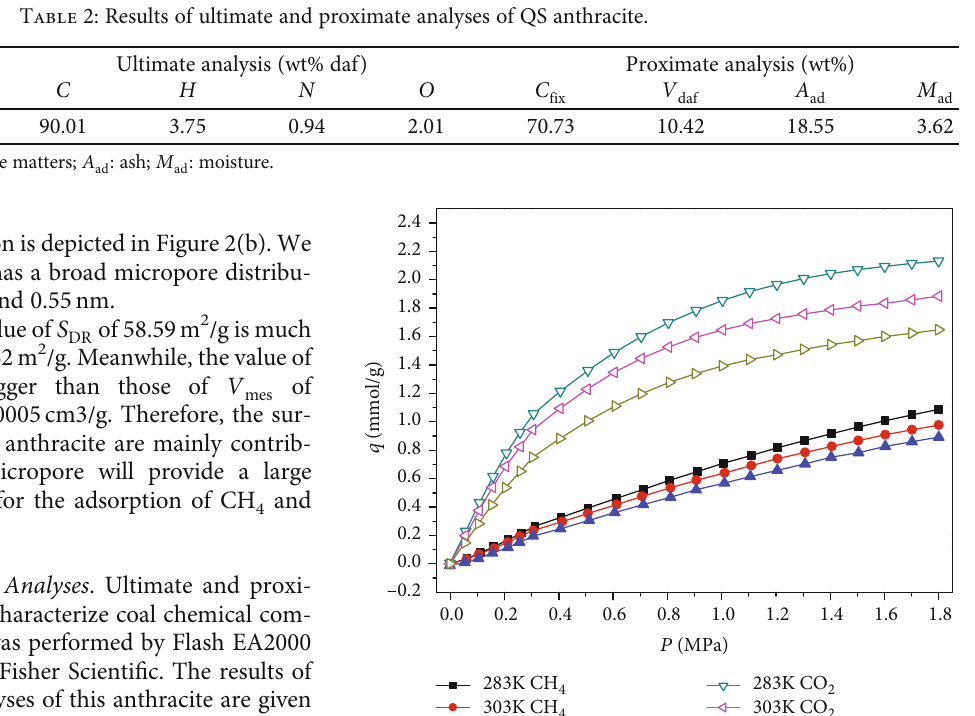
and CH at di ff erent 2 4